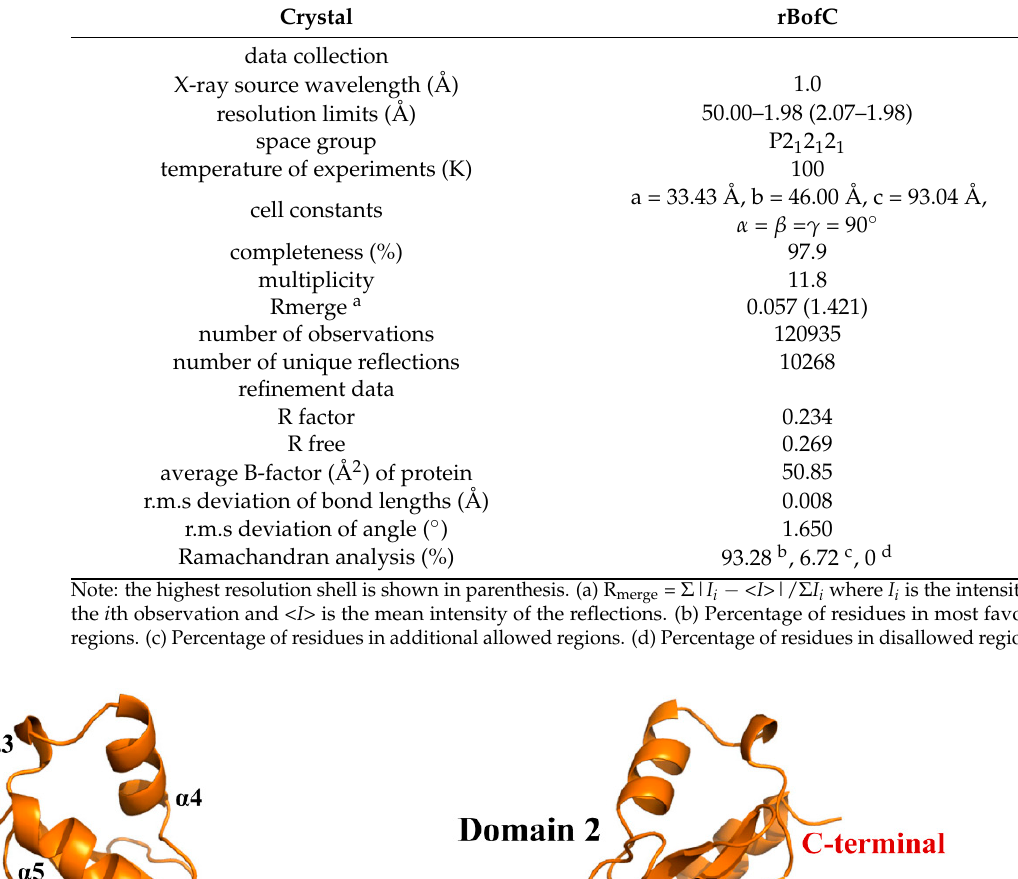
Table 1. X-ray data collection and model refinement statistics for rBofC crystal.